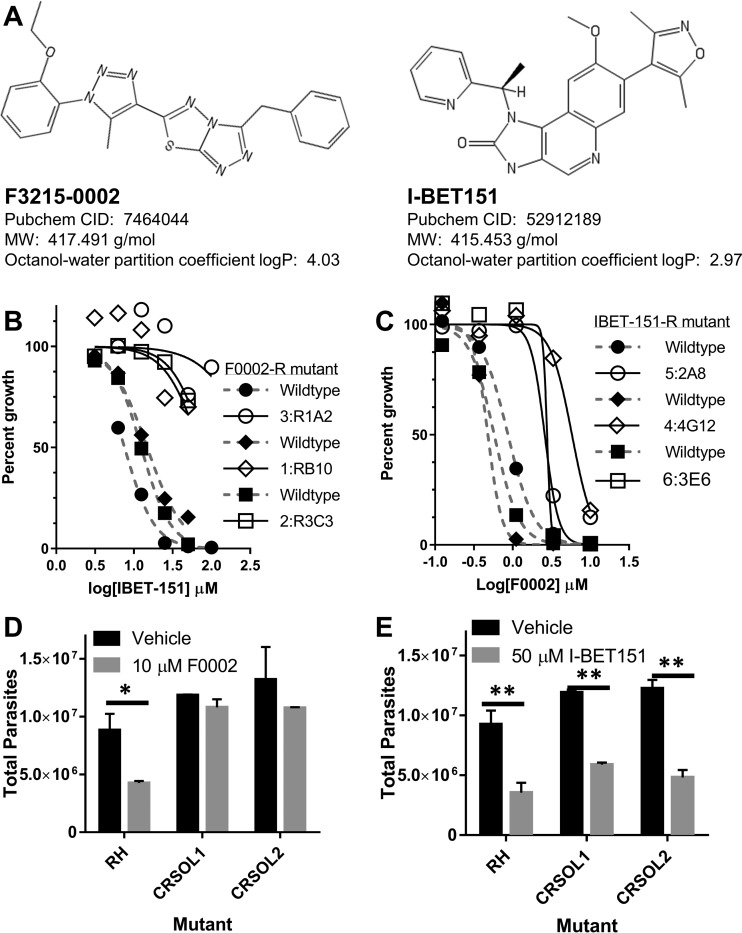
Quantification of drug cross-resistance between mutants selected for I-BET151 resistance and F0002 resistance. (A) Chemical structures of F3215-0002 (F0002) and I-BET151. PubChem identifiers and other properties relevant to their drug-like properties are listed. (B) Three F0002-resistant mutants were challenged in in vitro growth assays with 3.13 to 100 μM I-BET151, and the effect on parasite growth was assessed by direct parasite counting. All 3 mutants shown had significantly different dose-response curves (Table 2) and increases in IC50 values compared to wild-type assays performed in parallel (P < 0.05) (Table 2). All wild-type (filled shapes, dashed gray lines) and mutant (open shapes, black lines) fitted curves are shown and are paired by shape. n = 1 for each drug concentration for each mutant. IC50 and P values are listed in Table 2. (C) Six I-BET151-resistant mutants were challenged in identical assays with 0.123 to 10 μM F0002, and the effect on parasite growth was assessed by direct parasite counting. The 3 mutants shown (out of 6 total) had significantly different dose-response curves (P < 0.05) (Table 2) compared to wild type. Shape, line, and color are as in panel B. n = 1 for each drug concentration for each mutant. IC50 and P values are listed in Table 2. (D and E) Two TgPRELID F0002-resistant mutant clones generated by CRISPR/CAS9 and nonhomologous end-joining DNA repair were further tested for their resistance to 50 μM I-BET151 (E) and 10 μM F0002 (D) by direct parasite counting 24 h after drug exposure. Following 2-way ANOVA, all values were compared to RH with vehicle using post hoc tests as described in Materials and Methods. *, P < 0.05; **, P < 0.01, compared to RH with vehicle. n = 2 wells per strain-drug combination.